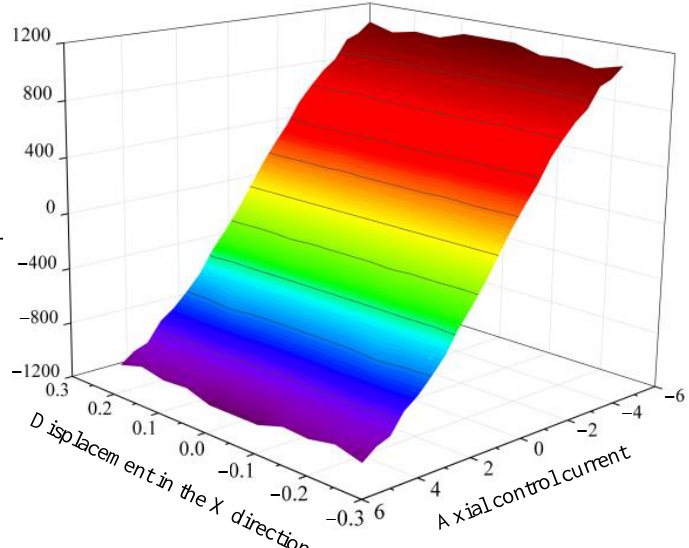
Figure 9. The influence of radial displacement on the axial suspension force–current characteristics.